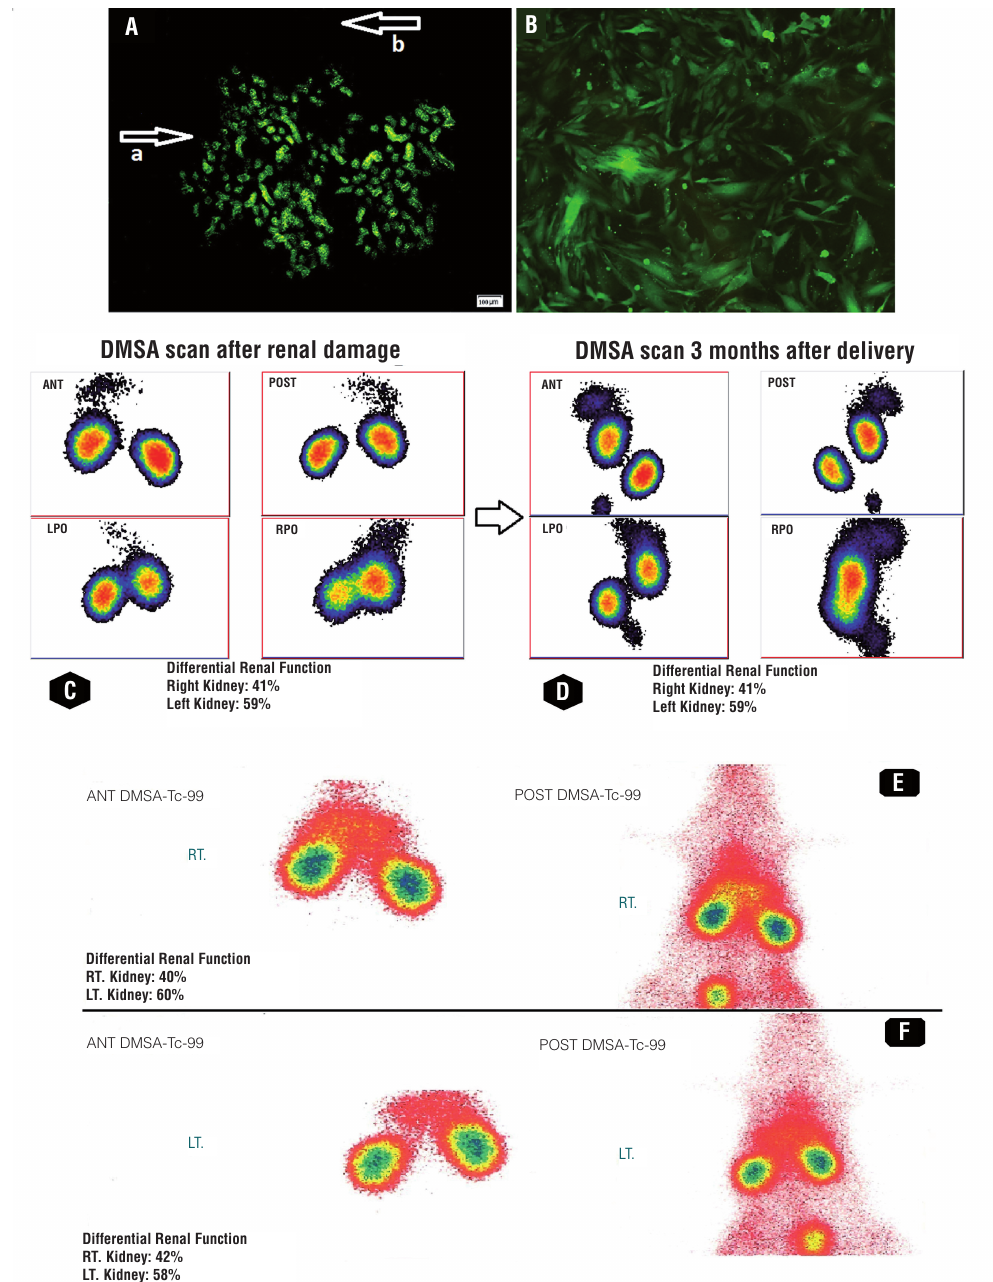
figure 1 - (A) Immunofluorescence of damaged part of maternal non-Gfp kidney. Arrow a shows the damaged part of maternal kidney which is covered by Gfp-positive fScs. Arrow b shows the undamaged non-Gfp maternal kidney; (B) fetal Gfp-positive cells in company with maternal non-Gfp renal cells after culture of the damaged part from the upper pole. Technetium-99m-DMSA scan of pregnant rats (experimental group); (c) differential renal function after induction of renal damage confirmed decreased renal function on right kidney; (D) Renal function was similar in both kidneys three months postoperatively. Technetium-99m-DMSA scan of non-pregnant rats (control group); (E) differential renal function after induction of renal damage confirmed decreased renal function on right kidney; (f) Renal function did not improve significantly three months after renal damage